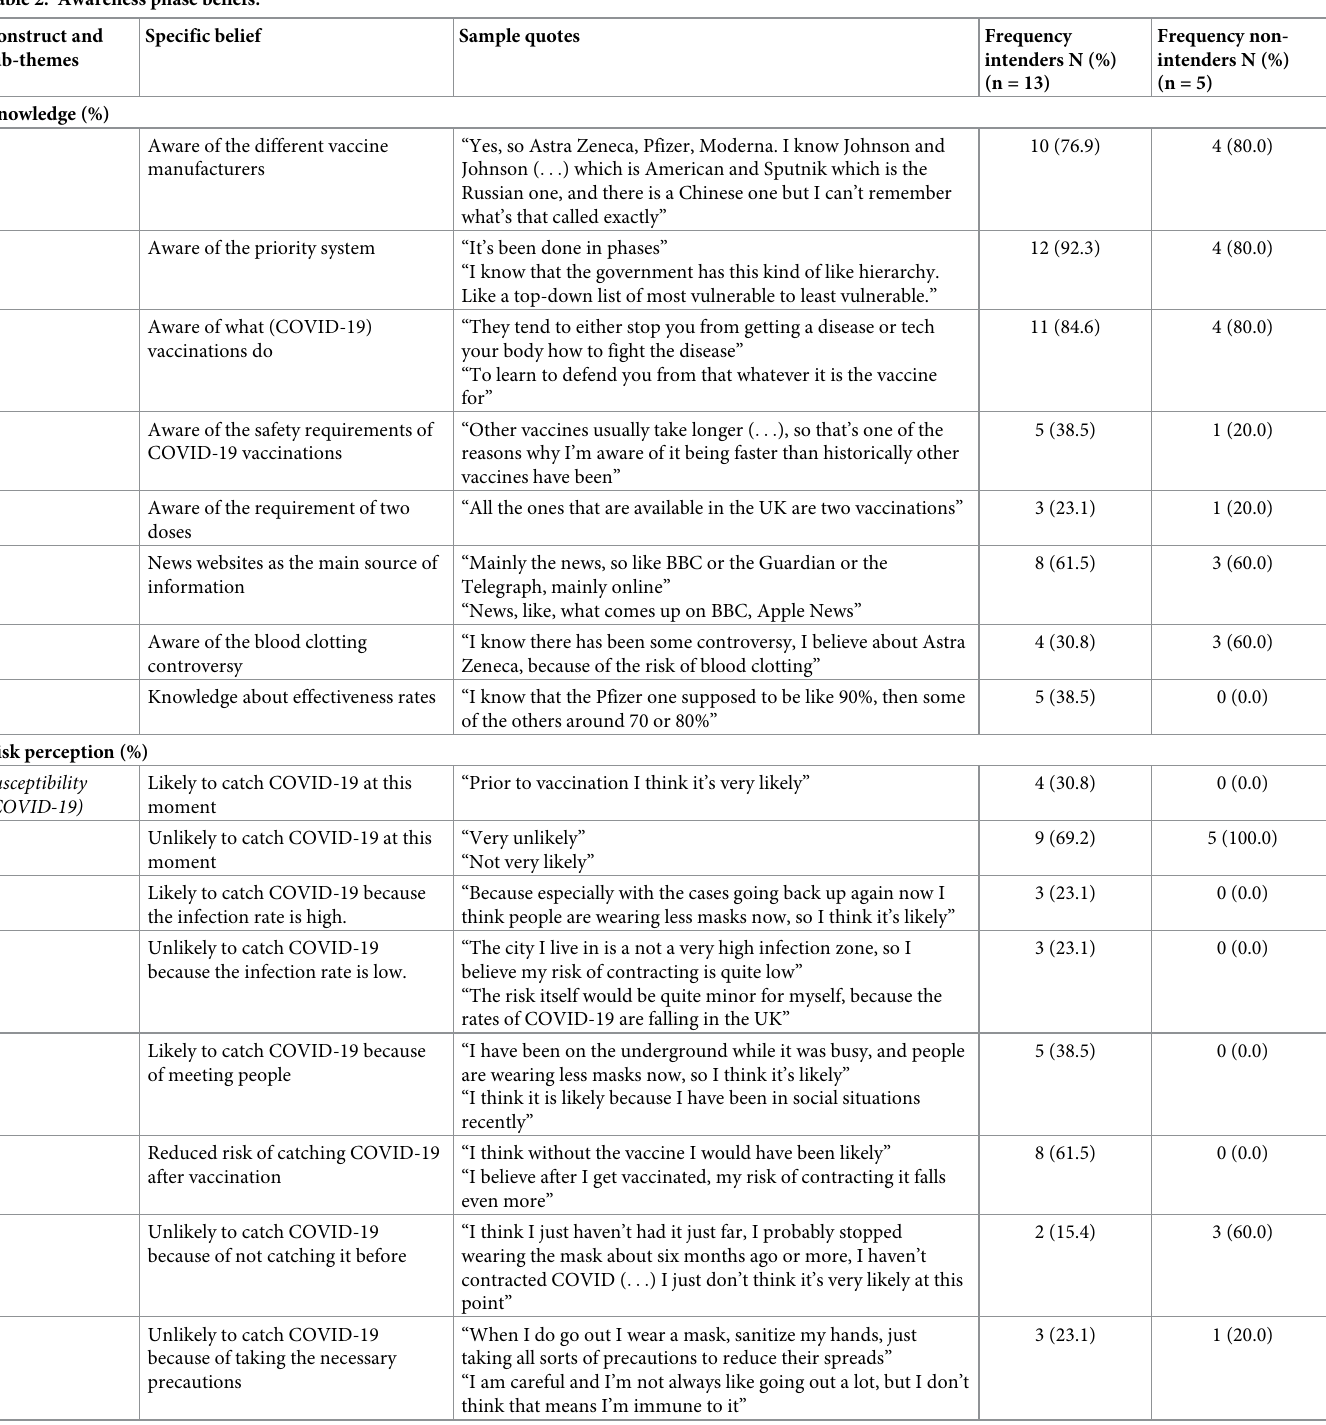
Table 2. Awareness phase